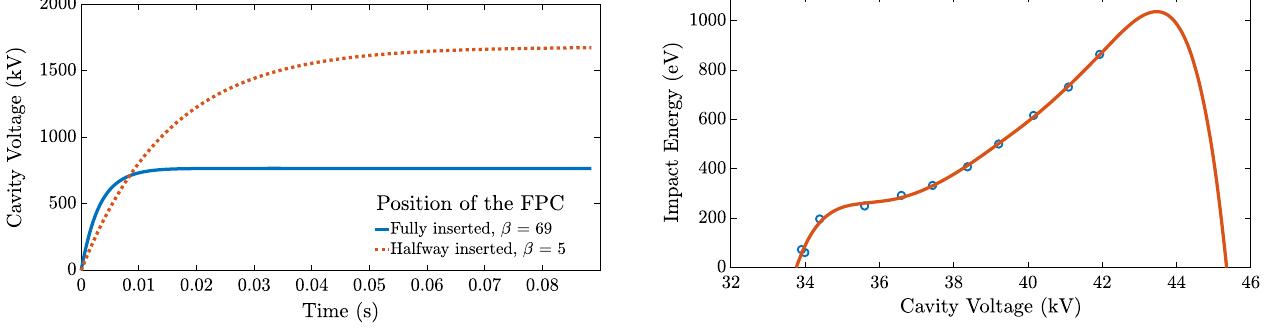
FIG. 16. Cavity voltage as a function of time for various positions of the FPC.